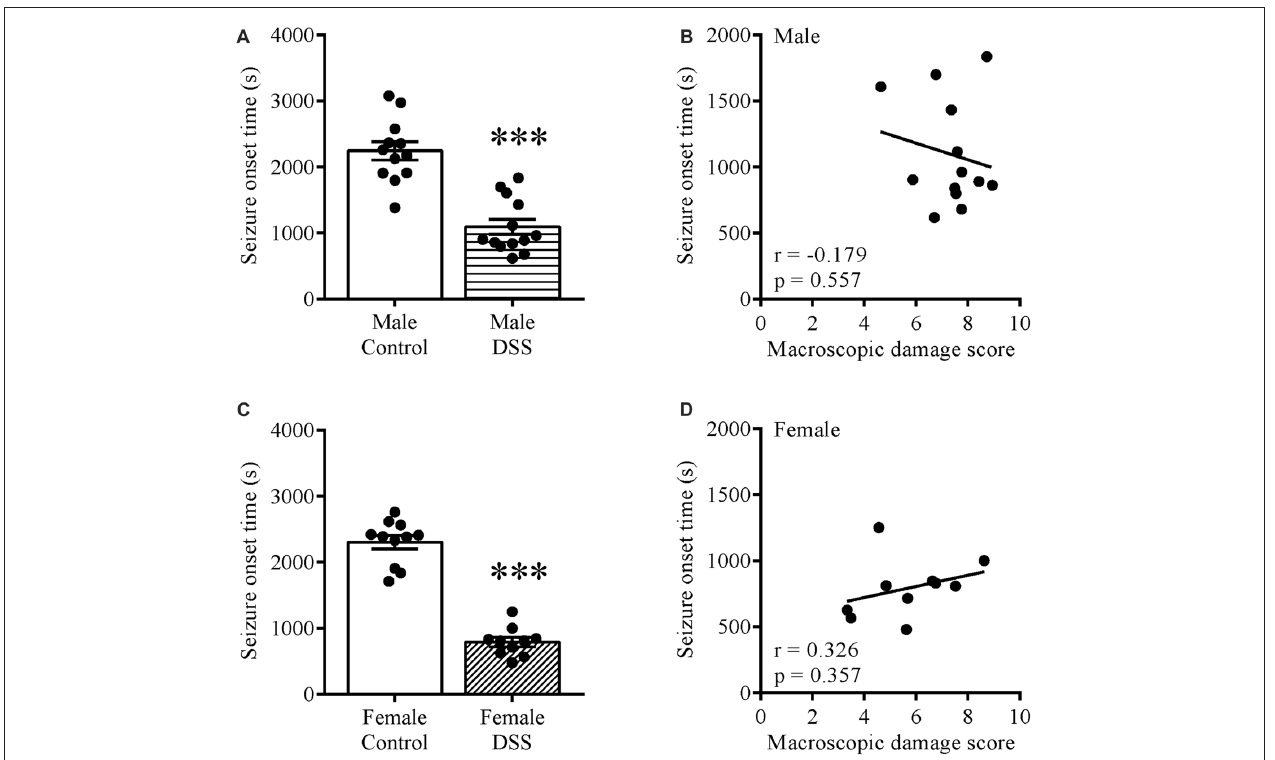
FIGURE 1 | Increased brain excitability in dextran sulfate sodium (DSS) colitis. Five days 2.5% DSS treatment decreased the seizure onset time in both males (A) and females (C) on day 7 (D7), and did not correlate with the macroscopic damage scores in males (B) nor females (D) . ∗∗∗ P < 0.001 vs. control mice.